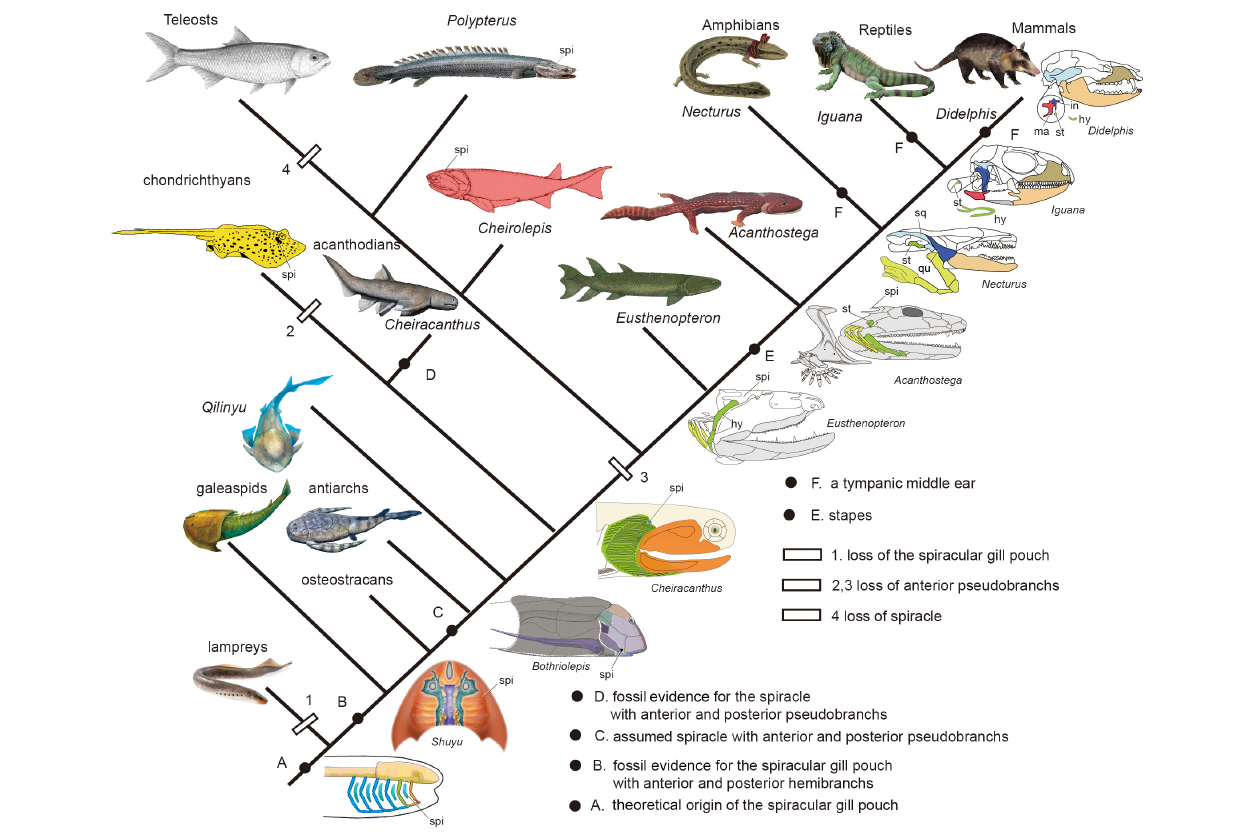
FIGURE 9 | The evolution of spiracular region from jawless fishes to tetrapods (Redrawn after Janvier, 1996b; Arsenault et al., 2004; DeLaurier, 2018; Burrow et al.,